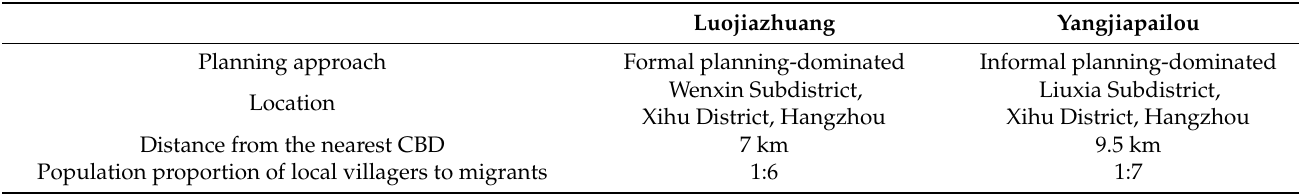
Figure 6. Topography of Luojiazhuang and Yangjiapailou. Table 1. The locations and basic information of the two urban